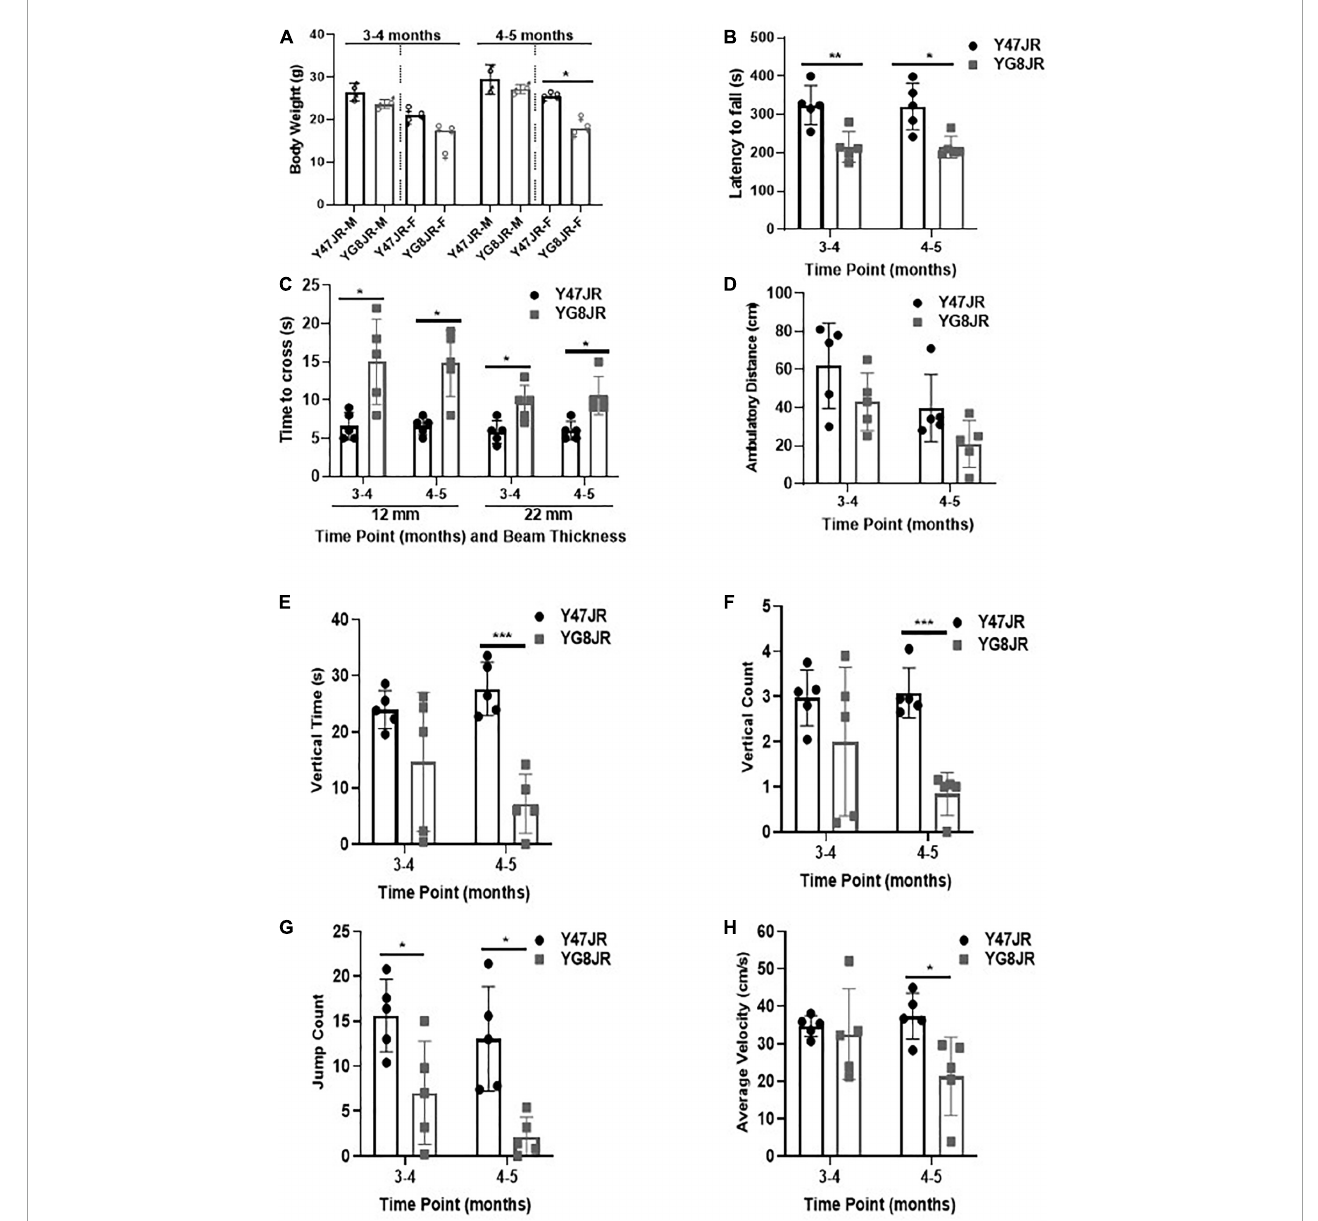
FIGURE1 Phenotypic and behavioral analysis of YG8JR FRDA mouse models. (A) Body weight (M, male; F, female) and (B) Rotarod analysis of YG8JR compared to Y47JR control mice at age 3–4 and 4–5 months old. (C) Beam-walk analysis of YG8JR compared to Y47JR control mice at age 3–4 and 4–5 months old using 22 and 12-mm beams. Locomotor activity analysis of YG8JR mice compared with Y47JR control mice assaying. (D) Ambulatory distance, (E) vertical time, (F) vertical count, (G) jump count, and (H) average velocity. Values represent mean ± SD. Asterisks indicate significant differences between YG8JR and Y47JR, assessed by unpaired two-tailed Student’s t -test ( n = 5 mice per genotype) on time points 3–4 and 4–5 months old (* p < 0.05, ** p < 0.01, *** p <